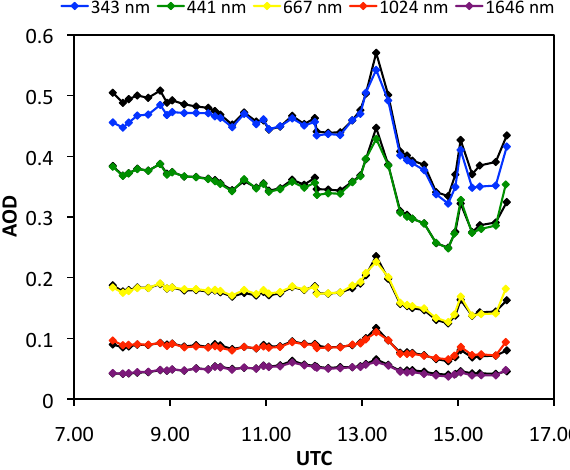
Fig. 3. Comparison of simultaneous ground-based measurements of PLASMA (colored lines) and CIMEL CE-318 (black lines) 18/04/2011.